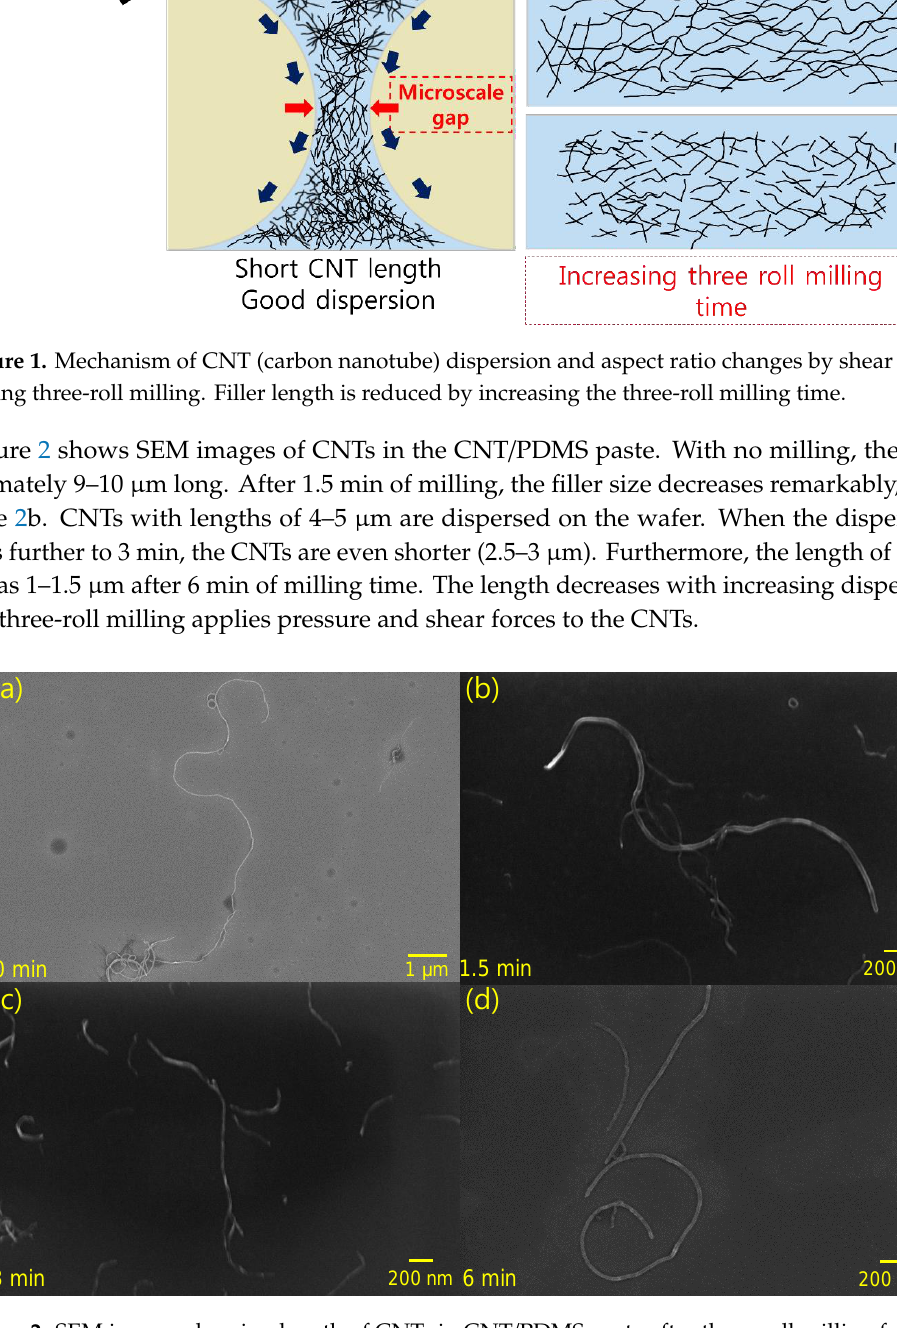
Figure 2. SEM images showing length of CNTs in CNT/PDMS paste after three-roll milling for ( a ) 0 min, ( b ) 1.5 min, ( c ) 3 min, and ( d ) 6 min.